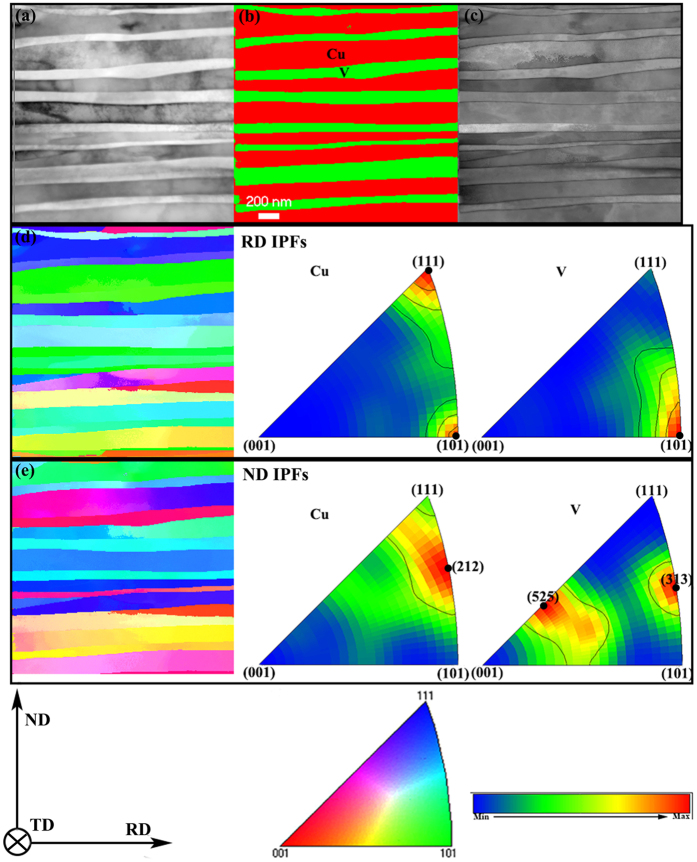
Phase mapping and orientation results of the CARB Cu/V nanocomposite with 100 nm layer thickness.(a) TEM bright field image for a representative PED scan region. (b) Phase map with Cu in red and V in green, exhibiting a fine lamellar structure with sharp Cu/V interface. (c) Virtual BF image from the PED system. Inverse pole figures of Cu and V, in which grains are colored with respect to their orientation as shown in the reference triangle. (d) RD-IPFs of Cu and V, in which the main orientation components are marked with black dots. (e) ND-IPFs of Cu and V, in which the main orientation components are marked with black dots. The predominant interface structures are Cu{212}<101>||V{525}<101> and Cu{212}<101>||V{313}<101>.